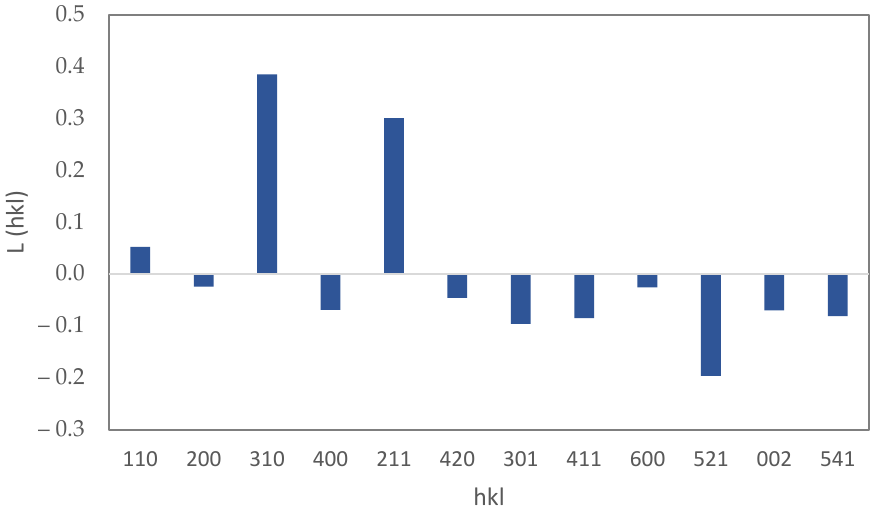
Figure 5. The Lotgering factor, L(hkl), for different crystallographic directions for the thin film sample of FeOOH.